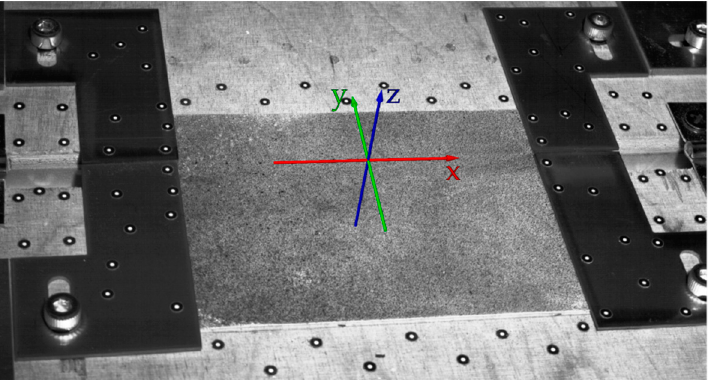
Figure 7. Position and orientation of the global coordinate system for the determination of the directional strains.